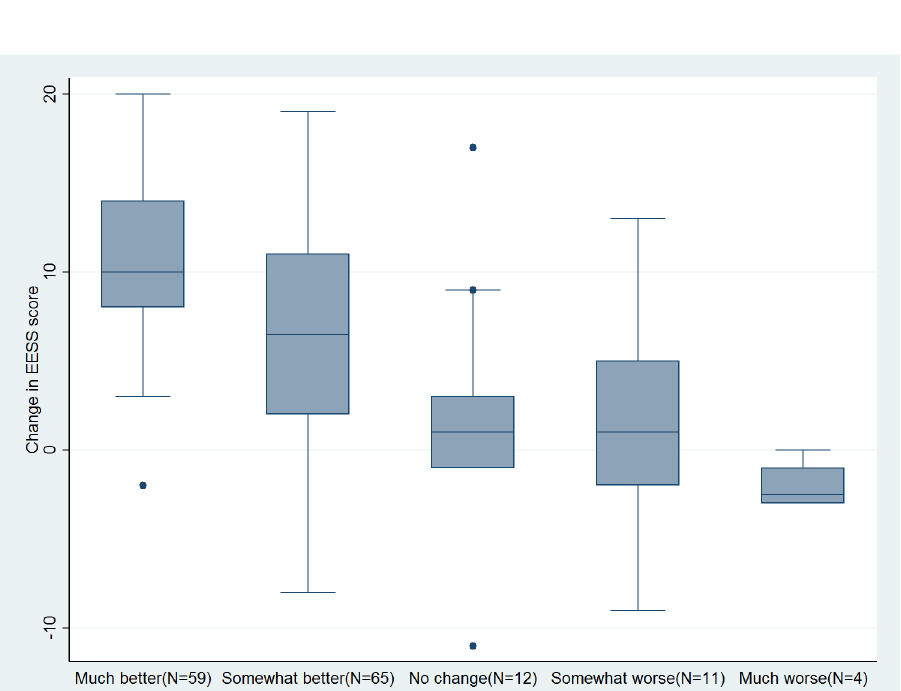
Fig 5. Change in EESS score and participant rated